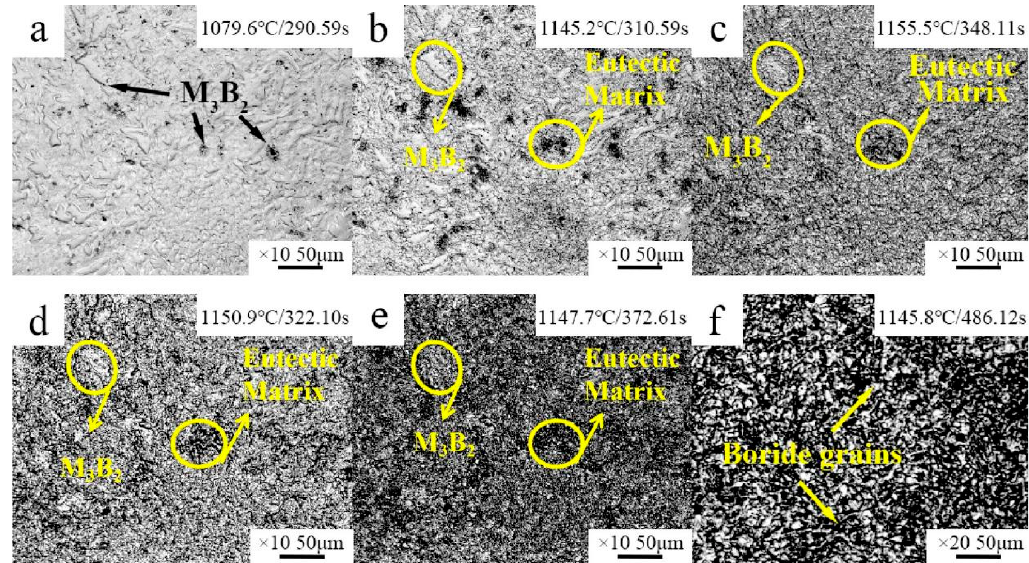
Figure 9. HT-CLSM snapshots of partial remelting of the Fe–Cr–Mo–Ni–B coating: ( a ) 1079.6 °C/290.59 s; ( b ) 1145.2 °C/301.59 s; ( c ) 1155.5 °C/348.11 s; ( d ) 1150.9 °C/322.10 s; ( e ) 1147.7 °C/372.61 s; ( f ) 1145.8 °C/486.12